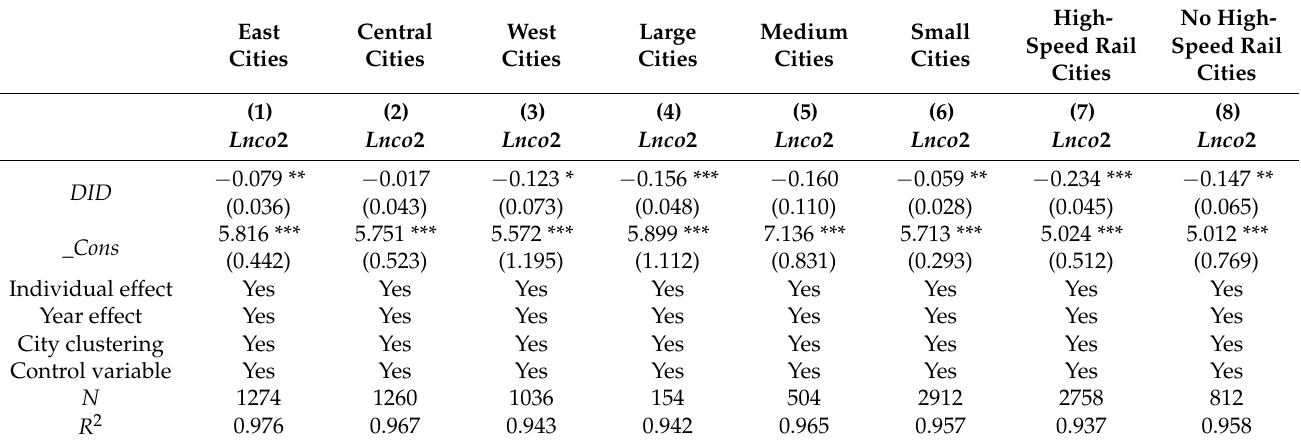
Table 4. Heterogeneity analysis.